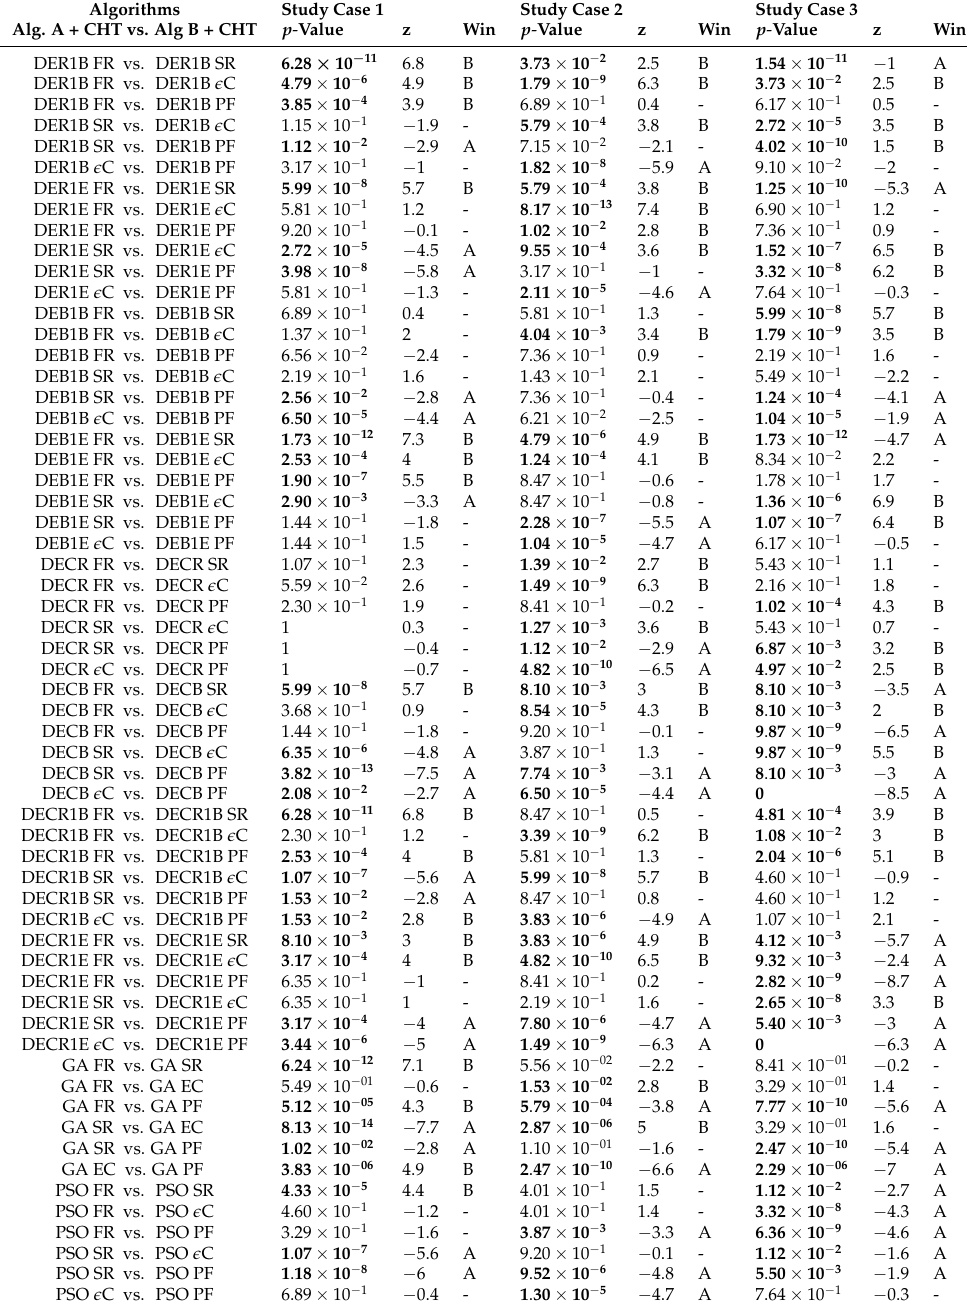
Table A25. Multiple comparison Friedman test with the post-hoc correction method for the overall performance of the four CHTs included into the ten metaheuristic algorithms for the PR metric. “-” indicates that there is no winning